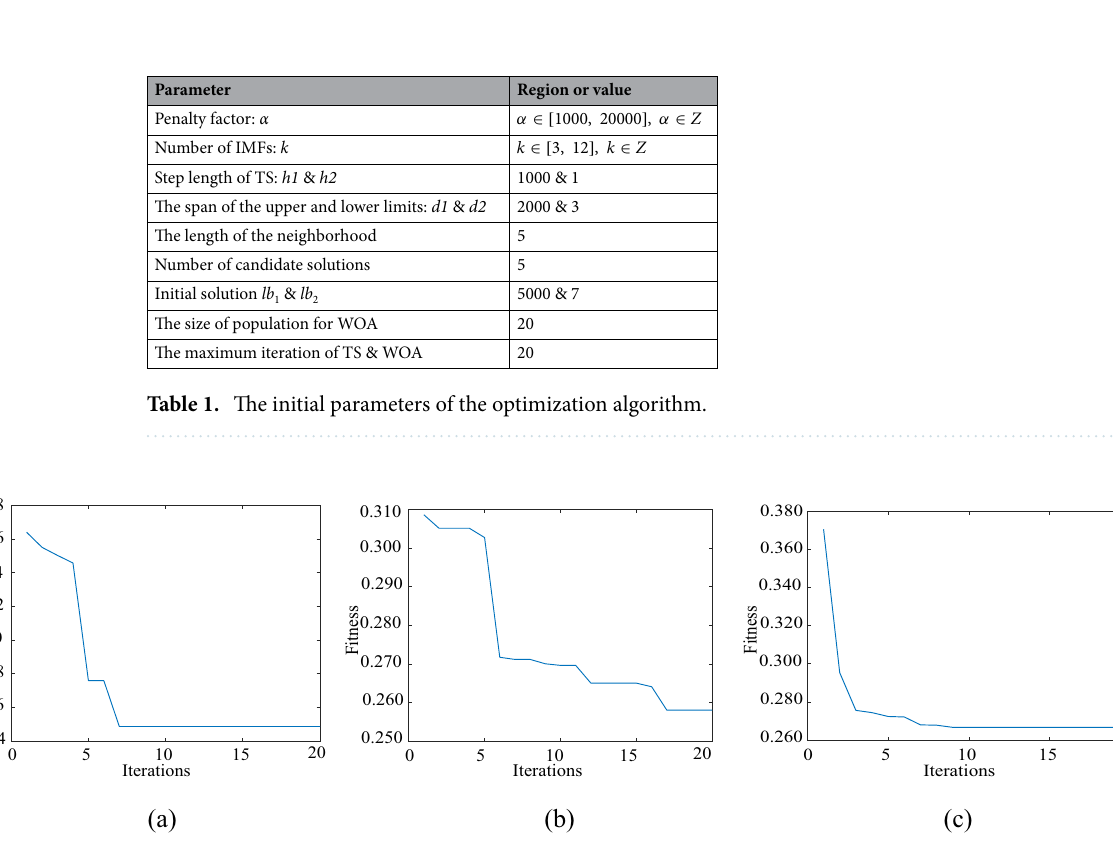
Figure 2. The iterative process of the proposed algorithm under 5 dB. ( a ) TS-WOA-VMD. ( b ) WOA-VMD. ( c )